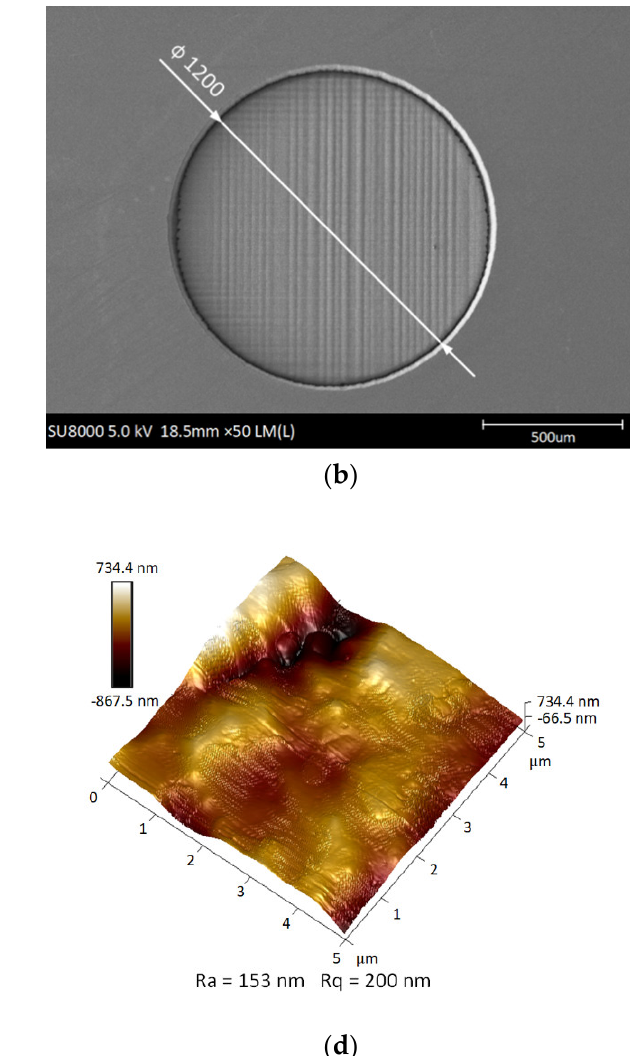
Figure 7. Depth and roughness of micro blind holes, which were all processed with the same set of parameters: laser average power of 1.5 W, lap of 15 and laser scanning speed of 125 mm/s.